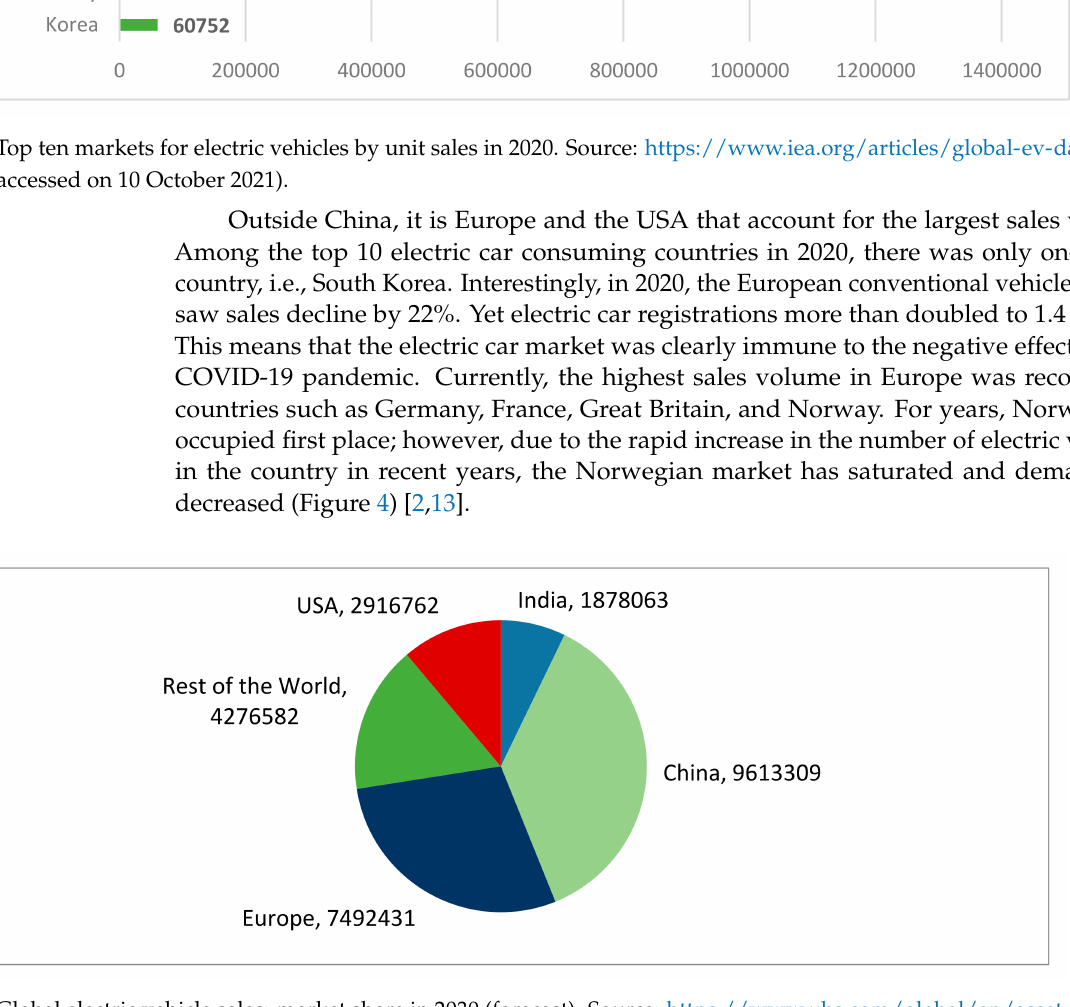
Figure 4. Global electric vehicle sales: market share in 2030 (forecast). Source: